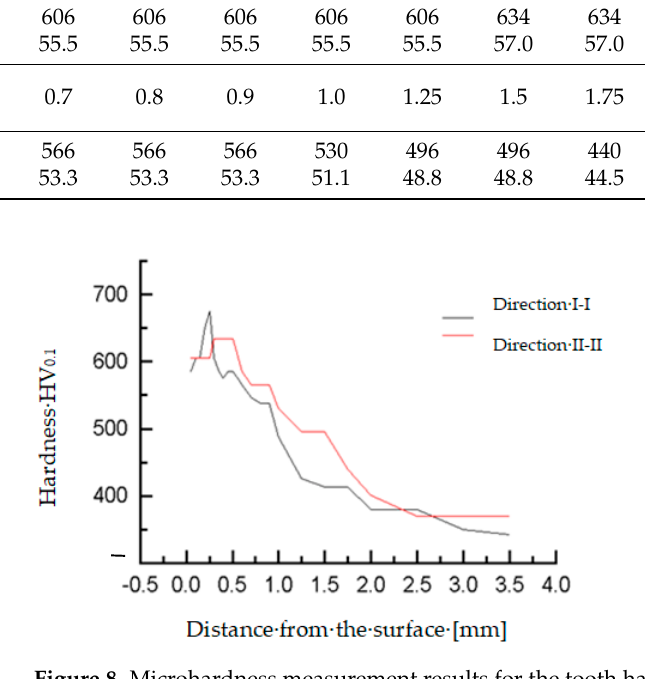
Figure 8. Microhardness measurement results for the tooth hard-faced with FM EVB2CrMo.